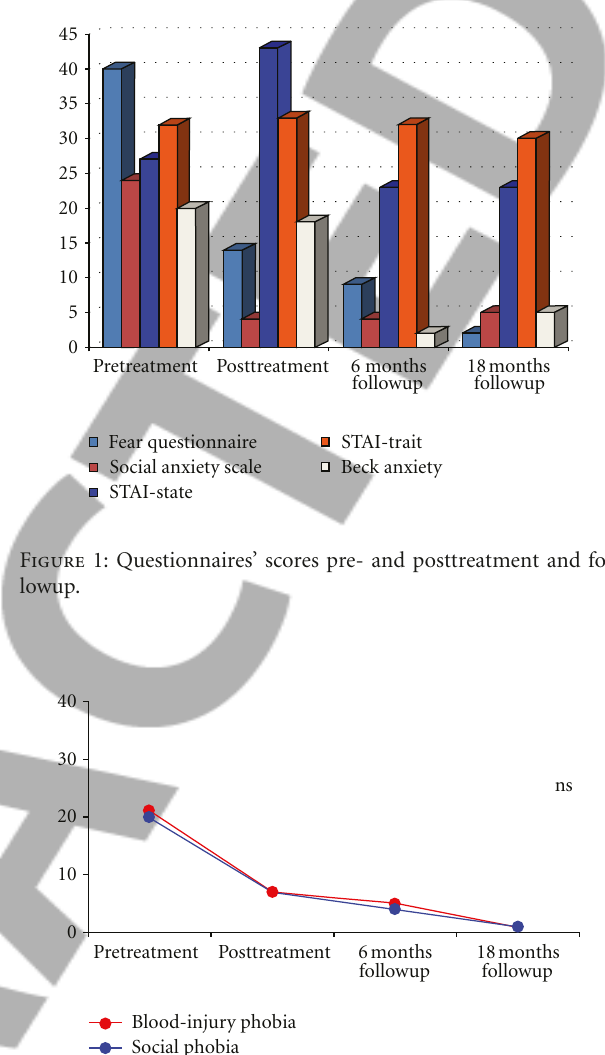
Figure 1: Questionnaires’ scores pre- and posttreatment and fol- lowup.